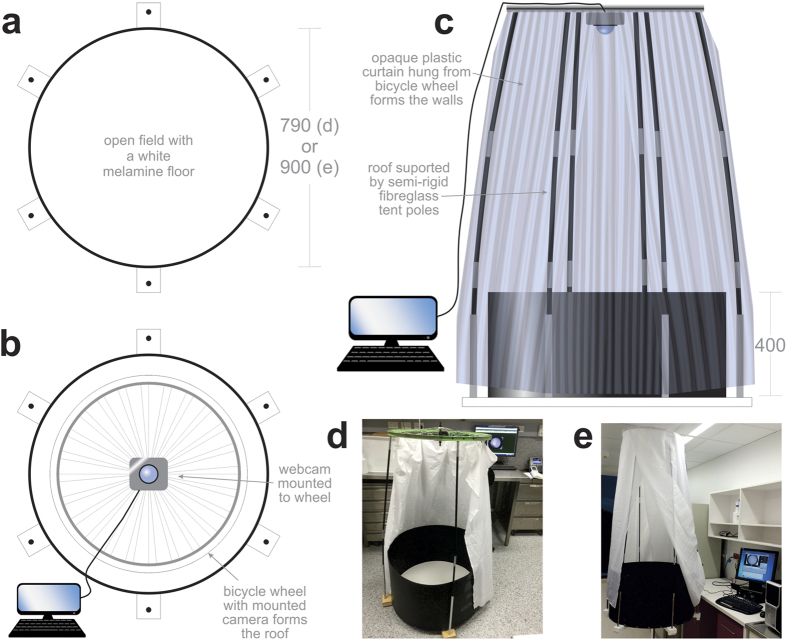
Design of the OFs used for testing MouseMove.Aerial perspective scaled drawing of our OF without (a) or with (b) its roof. (c) Side perspective scaled drawing of our OF. (d,e) Photos of OF #1 (d) and OF #2 (e) used to test MouseMove.